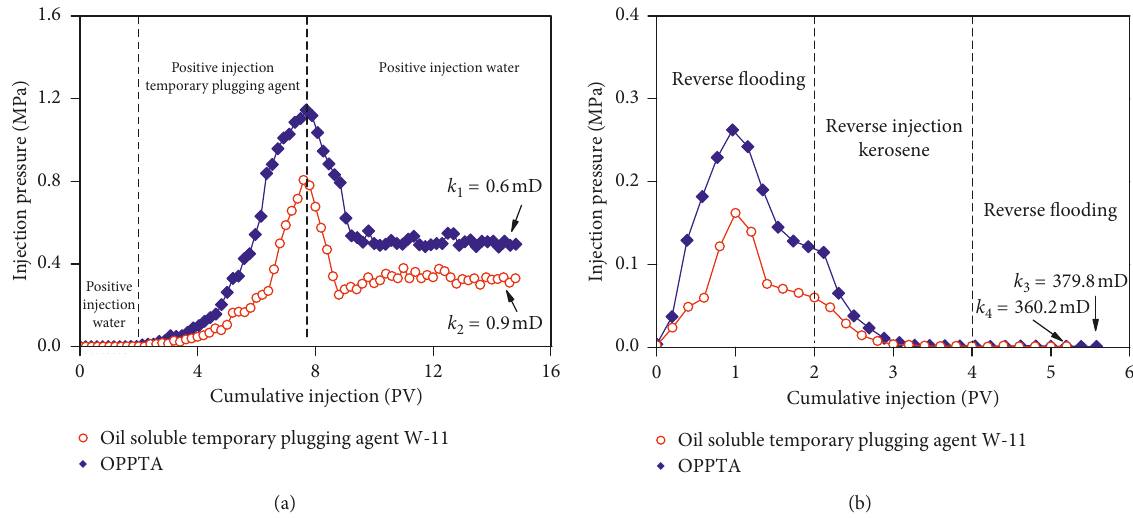
Figure 7: Temporary plugging effect of the temporary plugging agent on the crack: (a) sealing process; (b) plugging removal